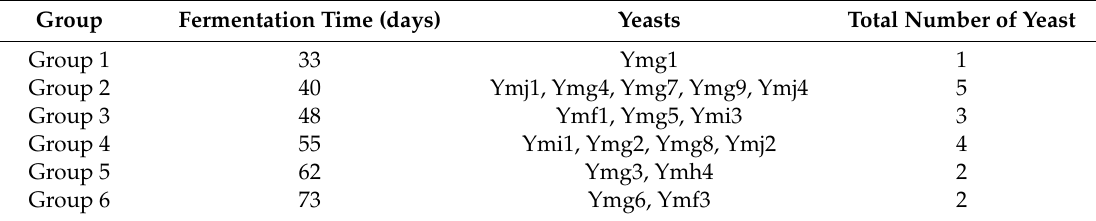
Figure 5. Fermentation process for the microvinifications. One density measurement per group is presented here from 33 to 73 days. Table 5. Fermentation time in days for the yeast strains. The strains were arranged in six groups according to their fermentation